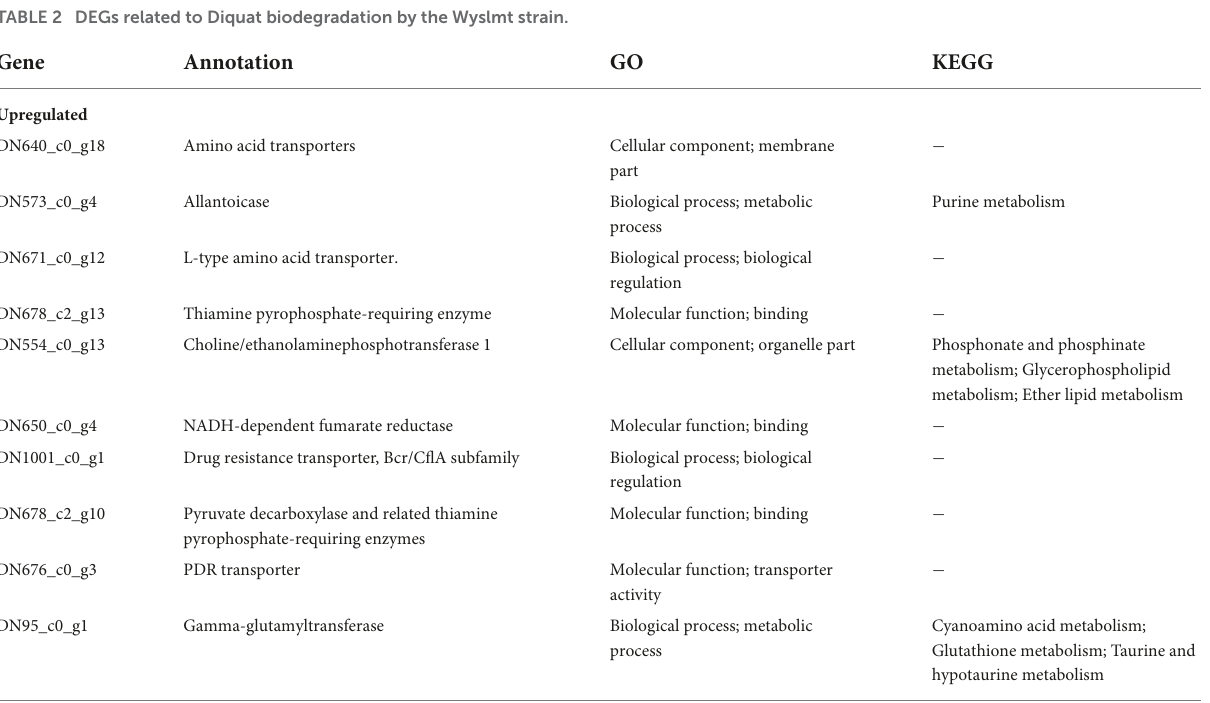
TABLE 2 DEGs related to Diquat biodegradation by the Wyslmt